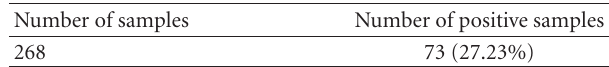
Table 5: Prevalence of Escherichia coli isolated from bovine mastitis. Number of samples Number of positive samples 268